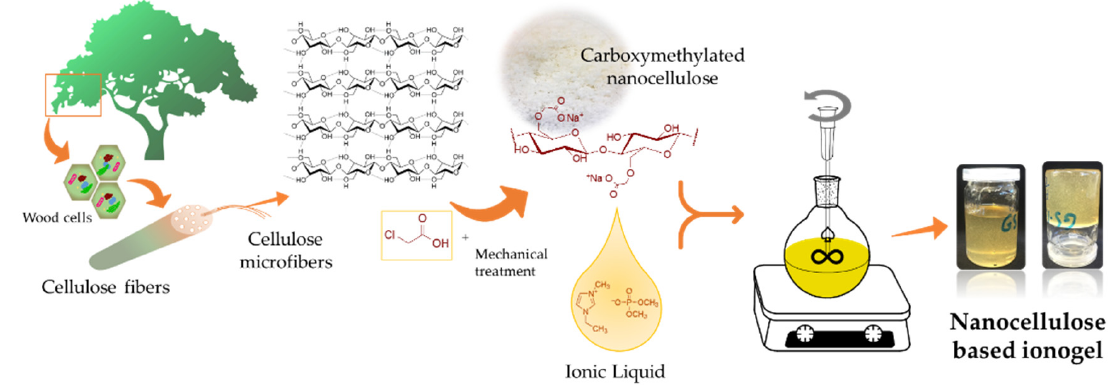
Figure 1. Schematic preparation of CNFc-based ionogels.